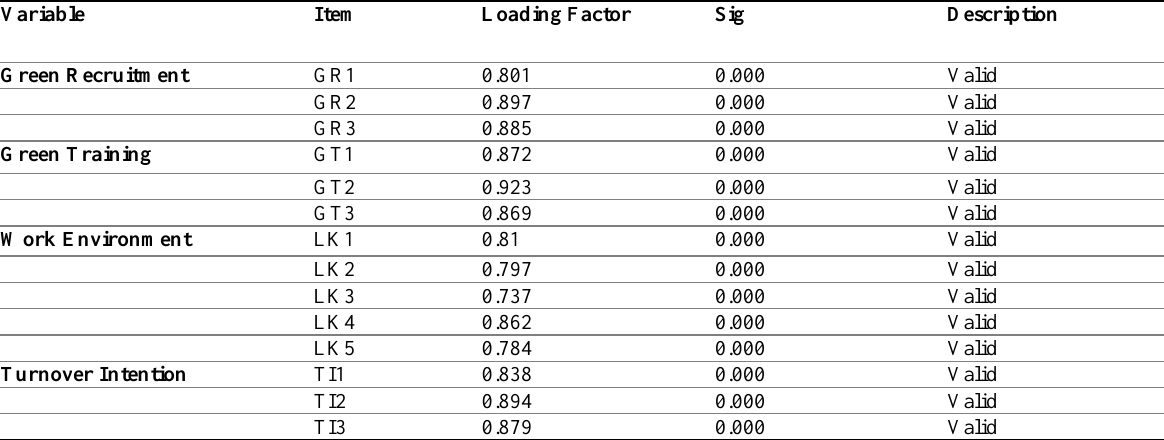
Table 2: Loading Factor Value Analysis